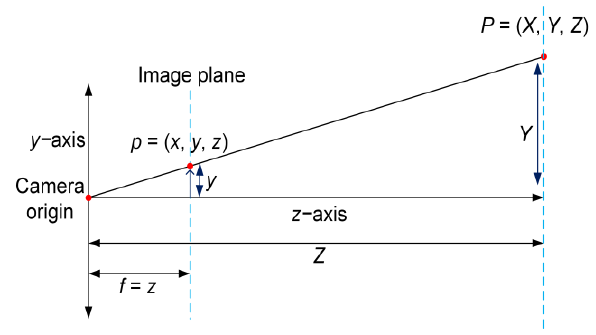
Figure 6. Perspective imaging model.